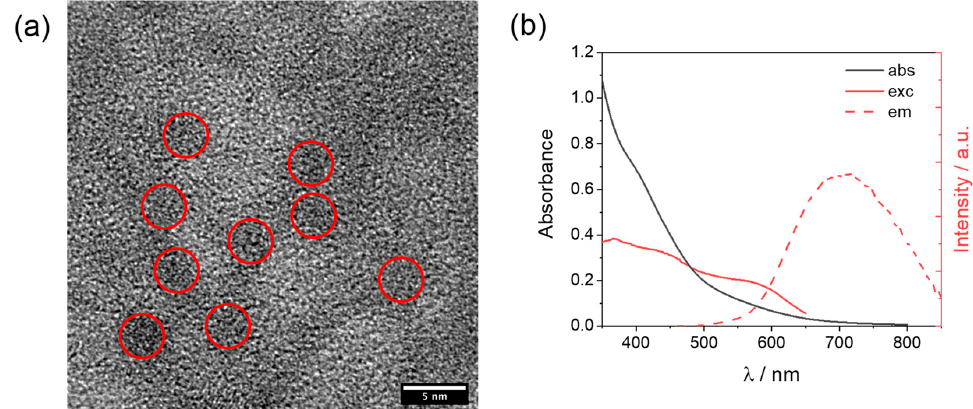
Figure 2. ( a ) High-resolution TEM image of aqueous CuInS 2 @ZnS QDs with red circles identifying discrete nanoparticles; ( b ) absorption, excitation (recorded emission at 700 nm), and emission (excitation at 450 nm) spectra of CuInS 2 @ZnS QDs in water.